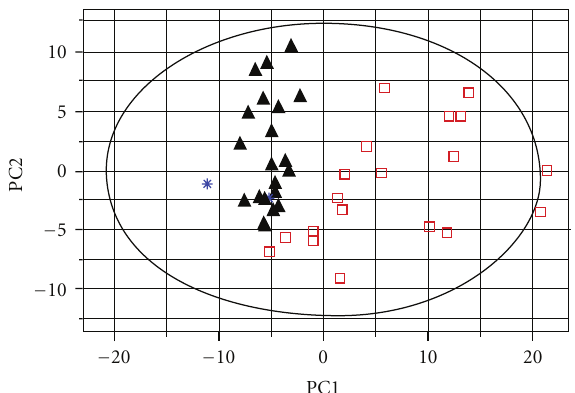
Figure 3: The plot of PCA analysis from two groups. “ (cid:2) ” showed the data from pregnant mice with CP fetuses in DEX group; “ (cid:3) ” showed the data from pregnant mice with fusion fetuses in control group. “ ∗ ” showed the pregnant mice including CP fetuses in the control group. Table 1: Comparison of the incidence of cleft palate in the embryos between two groups. Non-Fusion Fusion Total Incidence of non-fusion (%) Control group